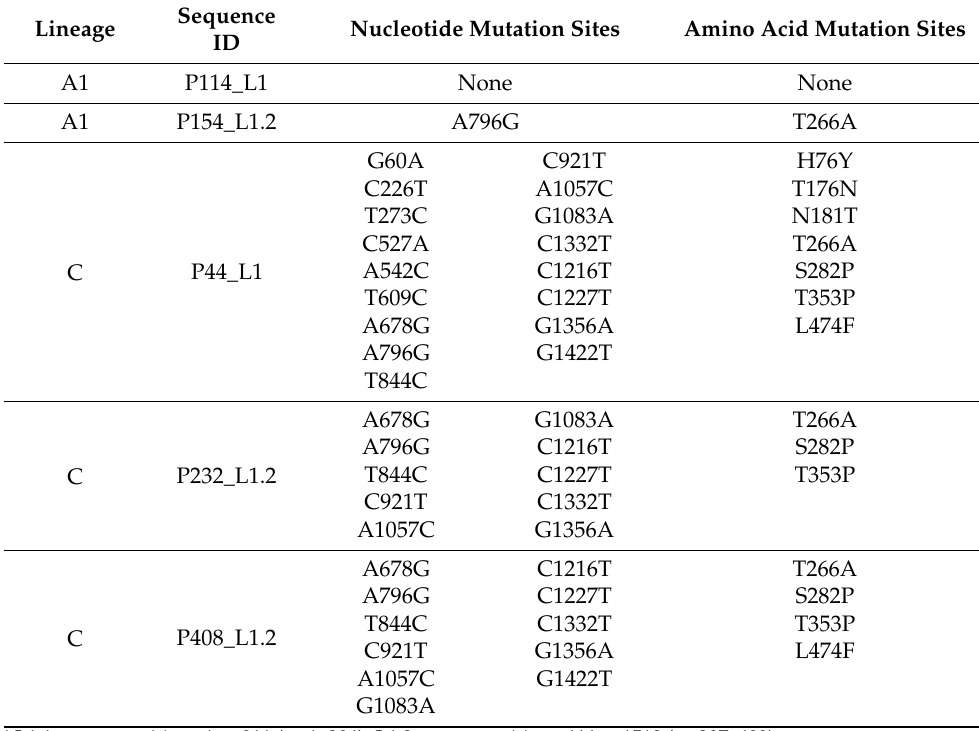
Table 2. L1 * nucleotide and amino acid substitutions by position and samples from Kinshasa